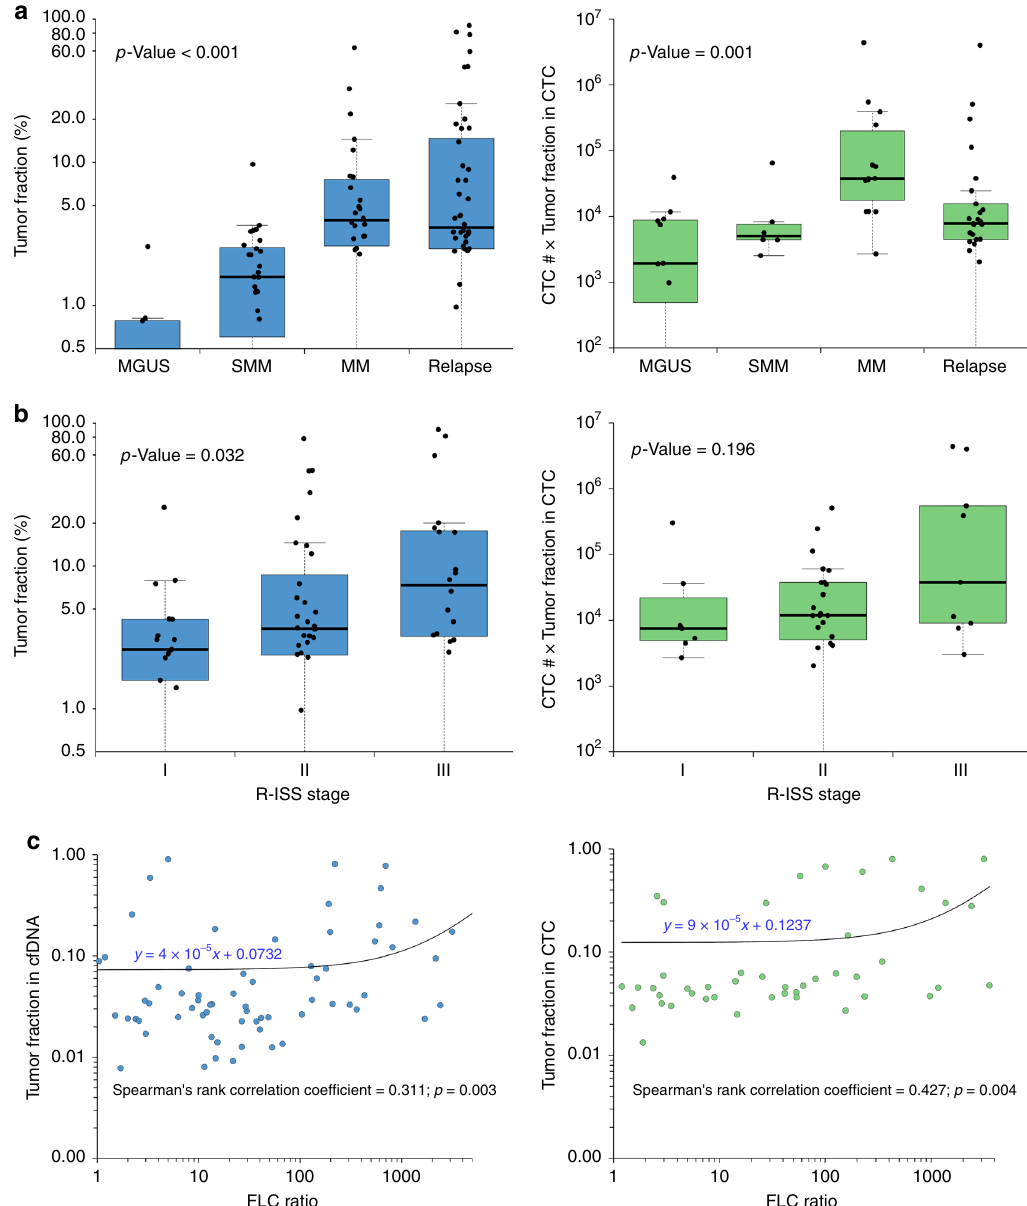
Fig. 2 Clinical correlation of CTCs and cfDNA in multiple myeloma. The distributions of tumor fraction (%) in each group are shown as boxplots, where the central rectangle spans the fi rst to the third quartile (interquartile range or IQR). A segment inside the rectangle shows the median, and whiskers above and below the box show the value 1.5 IQR above or below the third or the fi rst quartile, respectively. a Tumor fractions of cfDNA samples (blue) and CTC number × tumor fractions of CTC samples (green) correlate with clinical stage of MM patients. The comparisons of the tumor fraction in cfDNA and CTC among different disease status (MGUS, SMM, newly diagnosed MM, and relapse) were performed by using Kruskal – Wallis test ( p- value < 0.001 for cfDNA; p- value = 0.001 for CTC). b Tumor fractions of cfDNA samples (blue) correlate with ISS stage of MM patients, while CTC numbers × tumor fractions of CTC samples (green) do not. The comparisons of the tumor fraction in cfDNA and CTC among different R-ISS stages were performed by using Kruskal – Wallis test ( p- value = 0.032 for cfDNA; p- value = 0.196 for CTC). c Tumor fractions of cfDNA (blue) and CTC counts (green: number of CD138- selected cells × tumor fractions in CD138-selected pools) in samples correlate with FLC ratio of MM patients. The correlations between the tumor fraction in cfDNA/CTC and serum free light chain ratio were analyzed by Spearman ’ s rank correlation test (Spearman correlation coef fi cient = 0.311 and p -value = 0.003 for cfDNA; Spearman correlation coef fi cient = 0.427 and p -value = 0.004 for